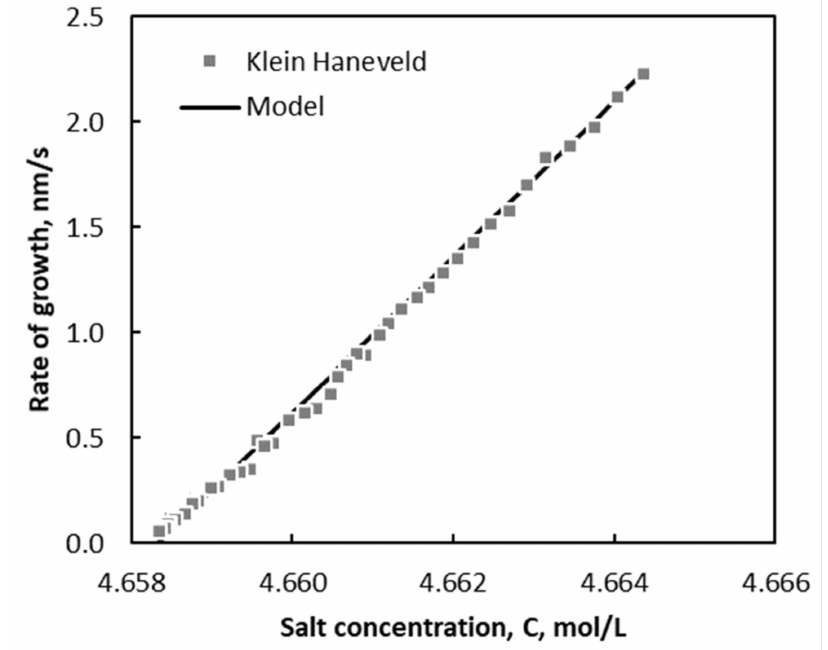
Figure 9. The rate of growth of KCl during crystallization showing linear kinetics. The points repre- sent data reported by Klein Haneveld [74], while the line represents the surface-vacancy model, Equa- tion (29), fitted to the data, with the replacement of sodium by potassium. See also Crundwell